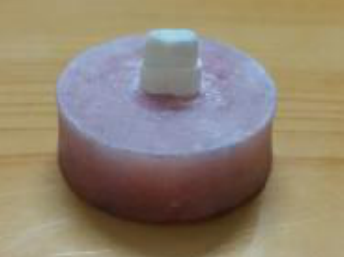
Figure 1: The final preparation of the tooth sample.